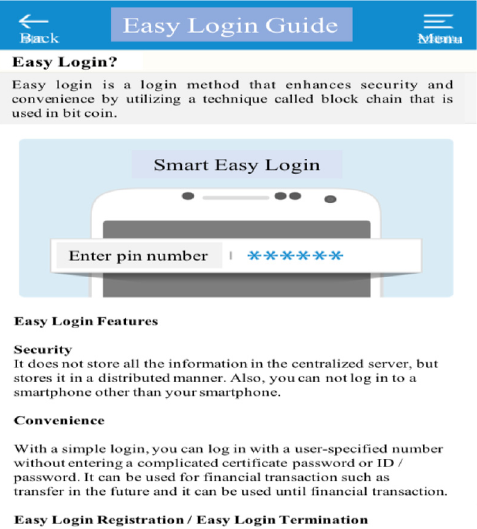
Figure 3. Blockchain-based easy login service of JB